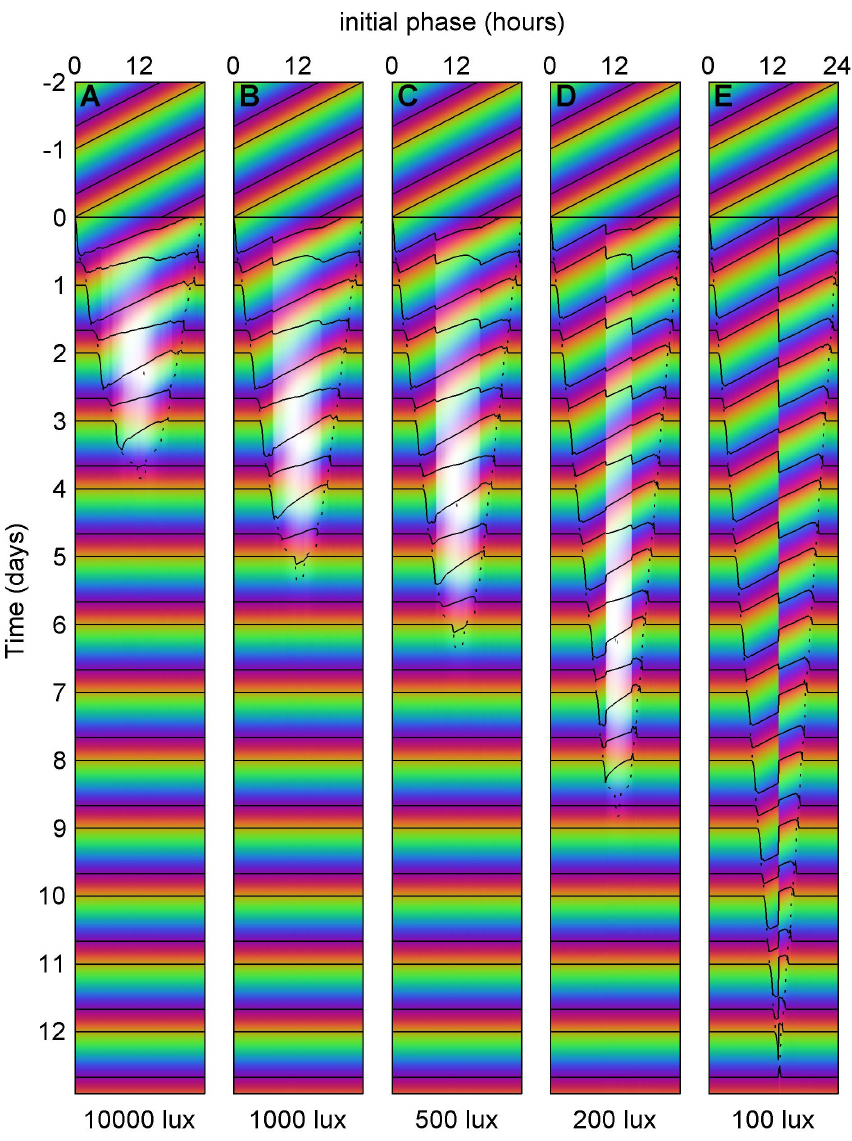
Figure 5. Predicted optimal circadian phase and amplitude for all phase shifts. The format is exactly the same as figure 4. Days 2 2 and 2 1 may be used as a legend associating a unique hue to each phase of the oscillator. Brightness is then used to represent amplitude, with white corresponding to zero amplitude [37]. The exact coloring, based on the state of the model variables, is shown in supplemental figure S3. Figure ( A ) shows the predicted phase and amplitude under the optimal schedules for resetting the clock when 10,000 lux light is available; ( B ) 1000 lux; ( C ) 500 lux; ( D ) 200 lux; ( E ) 100 lux.